Question: State the chart type depicted above.
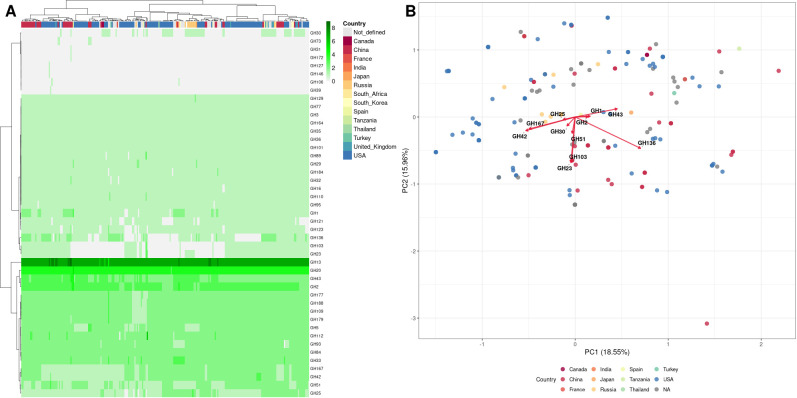
Answer: heatmap